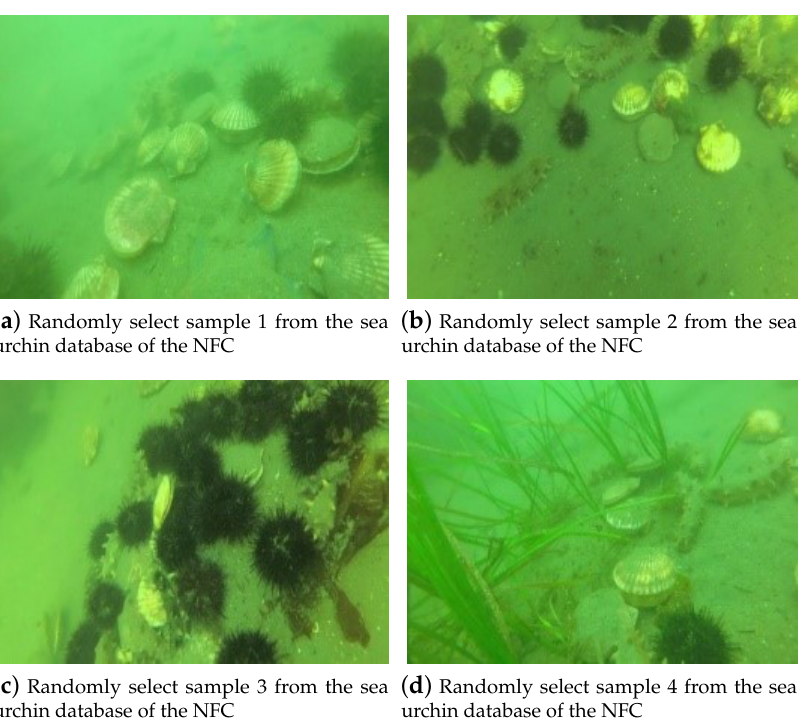
Figure 10. Underwater test images.